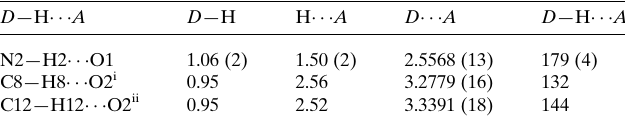
Table 6 Hydrogen-bond geometry (A˚ , (cid:4) ) for (V).